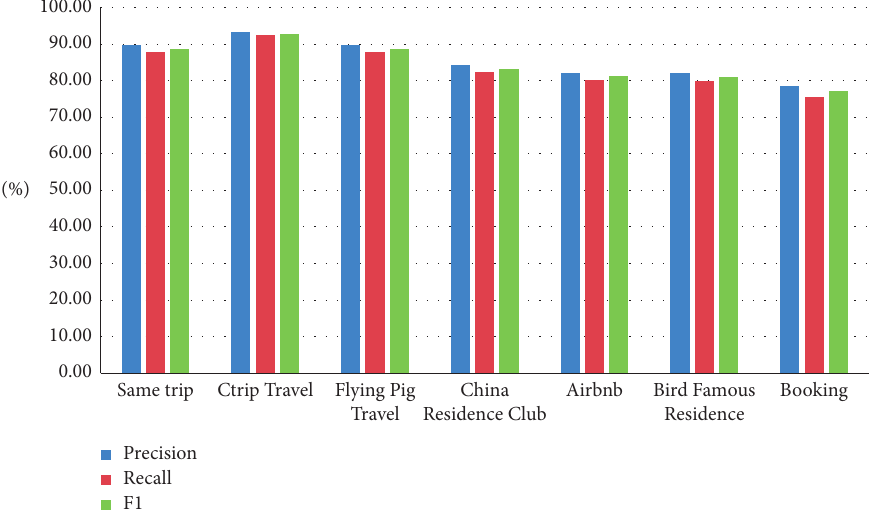
Figure 15: Comparison of hotel accommodation recommendation performance of tourism